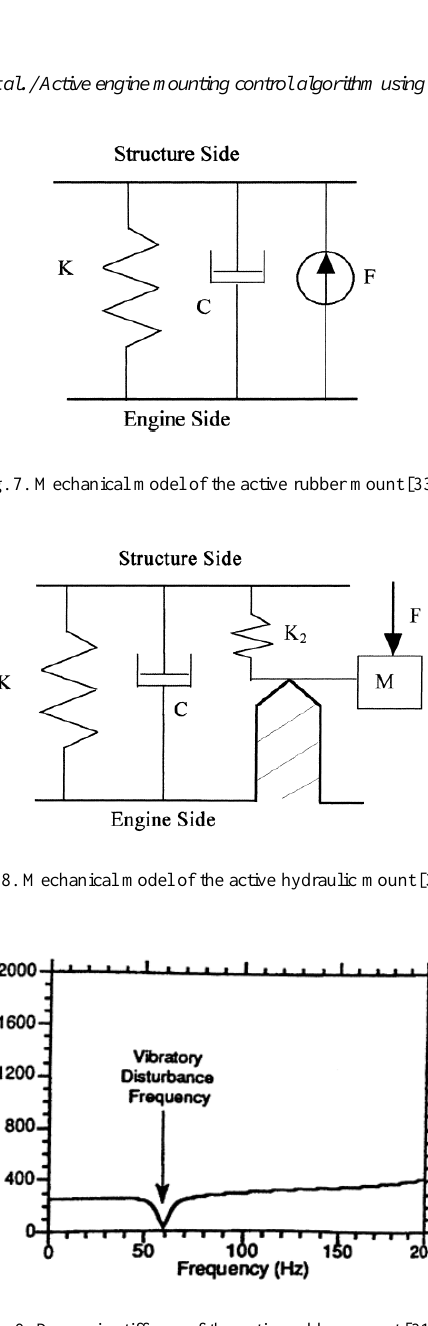
Fig. 9. Dynamic stiffness of the active rubber mount